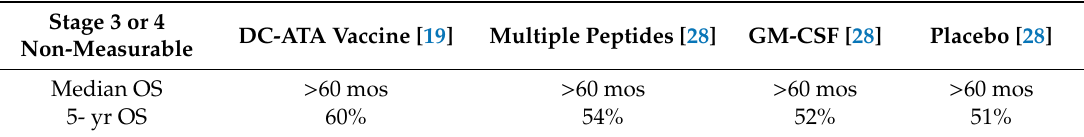
Table 3. Survival associated with immunotherapies for patients with prior stage 3 or 4 melanoma, but no measurable disease at the time of treatment.